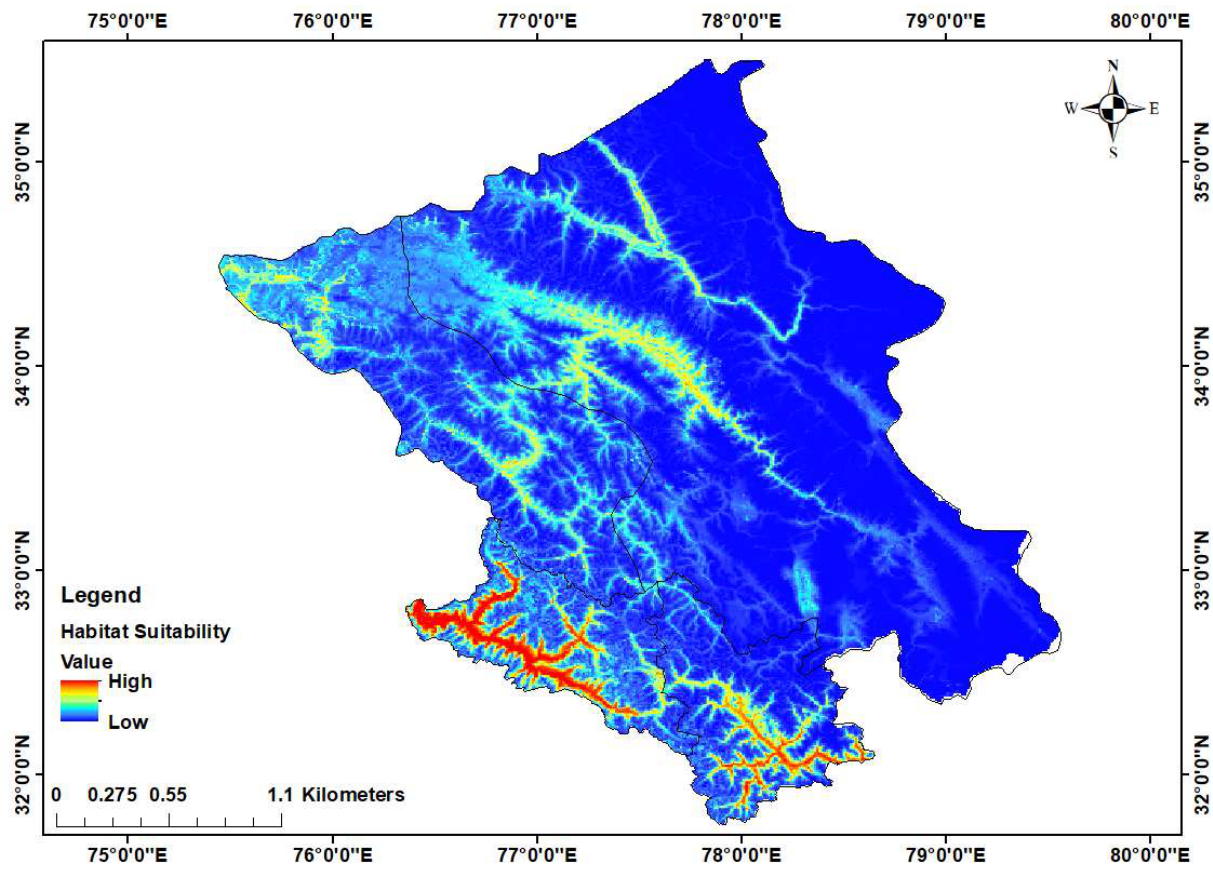
Figure 2. Habitat suitability map with higher suitability (red) and lowest suitability (dark blue) shows maximum suitability in Lahaul-Spiti region.